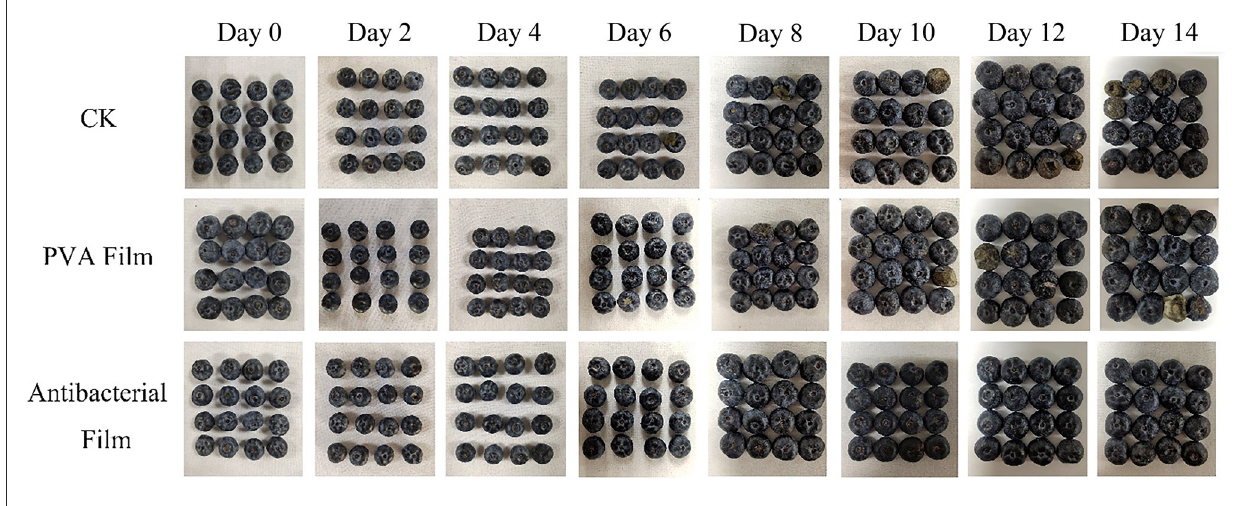
FIGURE8 Changes in the appearance of blueberries during